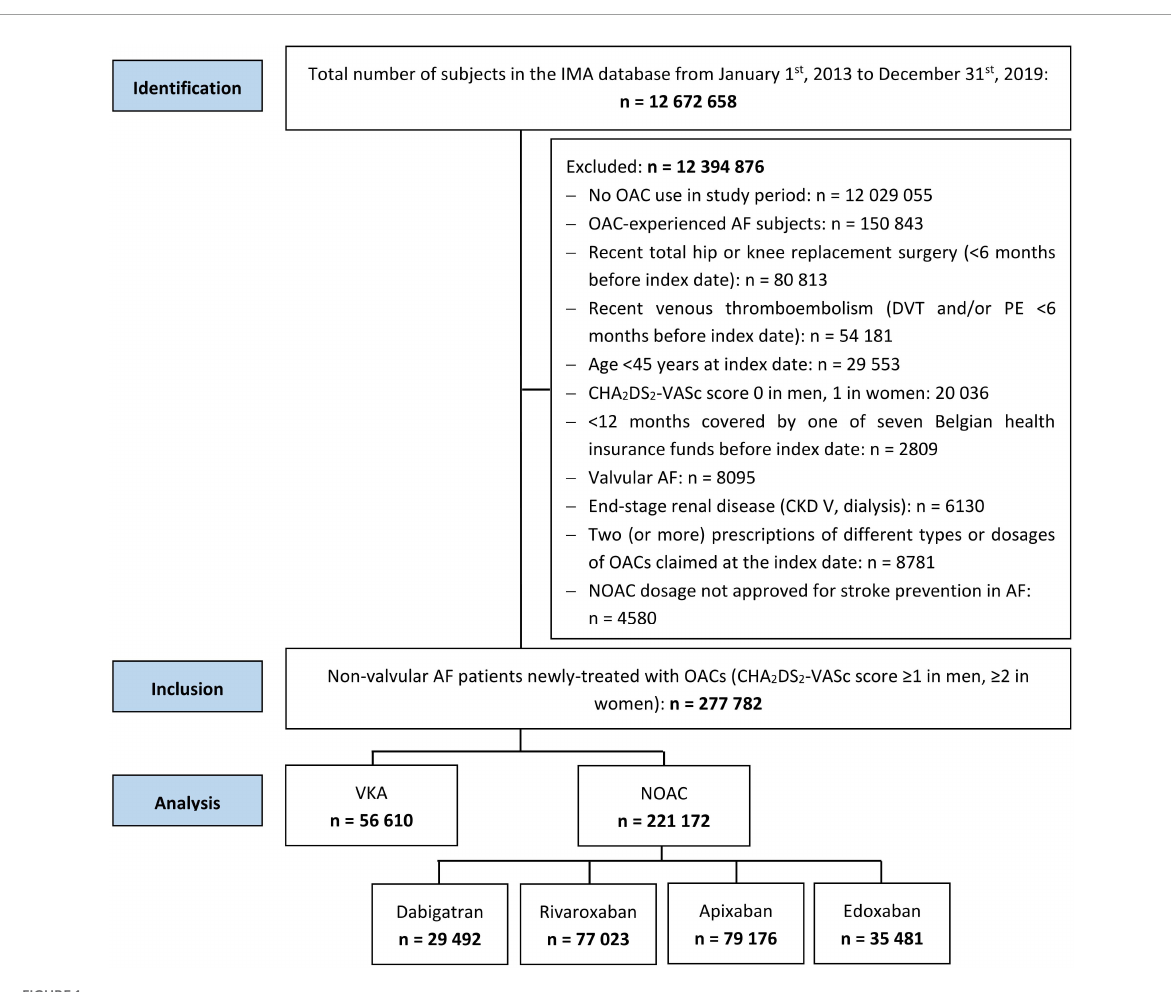
FIGURE1 Strengthening the reporting of observational studies in epidemiology (STROBE) diagram of study population. AF, atrial fibrillation; CKD, chronic kidney disease; DVT, deep vein thrombosis; IMA, InterMutualistic Agency; NOAC, non-vitamin K antagonist oral anticoagulant; OAC, oral anticoagulant; PE, pulmonary embolism; STROBE, Strengthening the Reporting of Observational Studies in Epidemiology; VKA, vitamin K